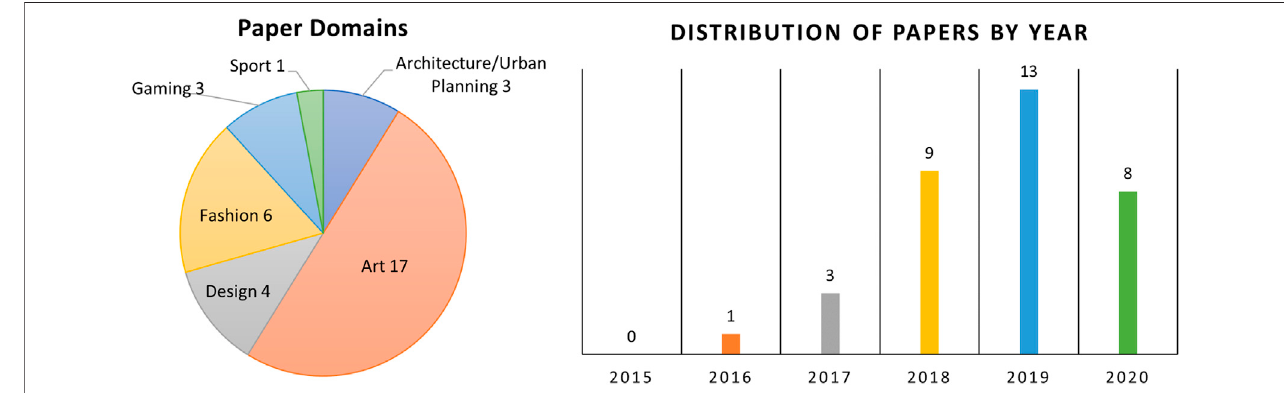
FIGURE 4 | Left: Categorization of articles by domain. Right: Distribution of surveyed articles by year, indicating an increase of academic interest in this area.